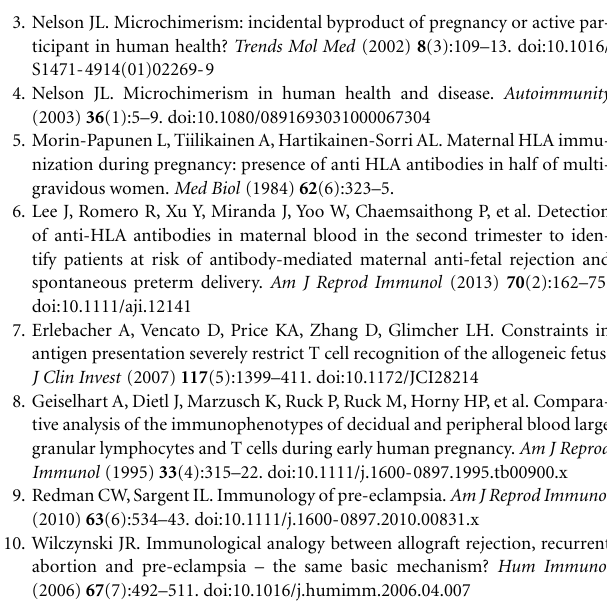
FIGURE 3 | Summary of proposed innate and adaptive interactions in human pregnancy . Decidual DC-SIGN + APCs appear to be a central player in these interactions. dNK cells interact with DC-SIGN + APCs via ICAM3, this leads to release of IFN γ , which in turn upregulates IDO in DC-SIGN + APCs, as well as inhibitingTh17 cell differentiation.The tolerogenic DC-SIGN + APCs function to induce iTreg cells from naïve CD4 + T cells (Th0),Treg cells in turn regulated DC-SIGN + APCs via CTLA-4 and B7 (CD80 and CD86) interaction, further increasing IDO expression. IL-10 from dNK cells and DC-SIGN − dMacs acts to upregulate HLA-G expression by DC-SIGN + APCs; the HLA-G is then